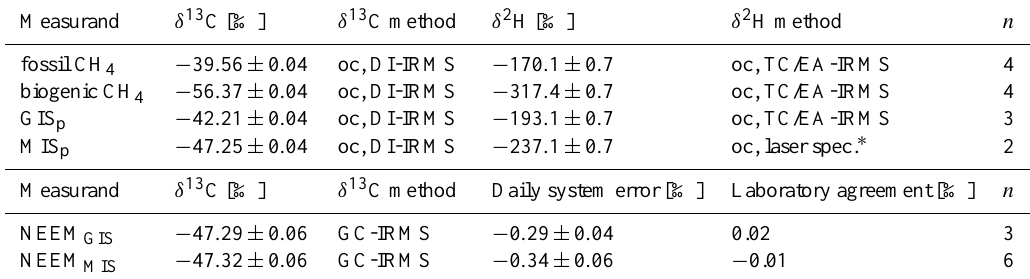
Table 2. Mean δ 13 C and δ 2 H isotope values of pure CH 4 gases (top panel) and of NEEM, measured with the produced isotope reference gases (bottom panel). The calculations of the uncertainties are explained in Sect. 3 and are based on n repetitive measurements. “oc” denotes the offline combustion method, DI-IRMS refers to Dual Inlet IRMS and laser spec. indicates δ 2 H measurements by laser spectroscopy. The ∗ indicates the δ 2 H measurements that needed correction for a 4.4‰ system offset (Sect. 3). The indices GIS and MIS indicate the applied isotope reference gas for the measurement of NEEM. The laboratory agreement shows the difference between the referencing of NEEM with our GC-IRMS setup and our produced isotope reference gases compared to the mean value of the two external laboratories. Our GC-IRMS system can currently not measure δ 2 H-CH 4